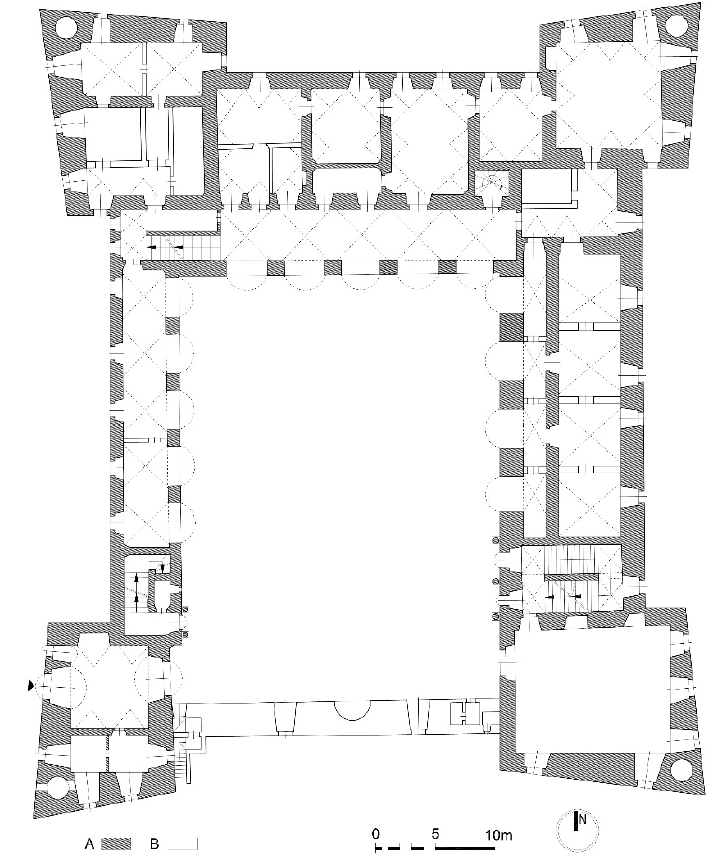
Figure 13. Nalahozeves castle: ground floor plan; created by authors.